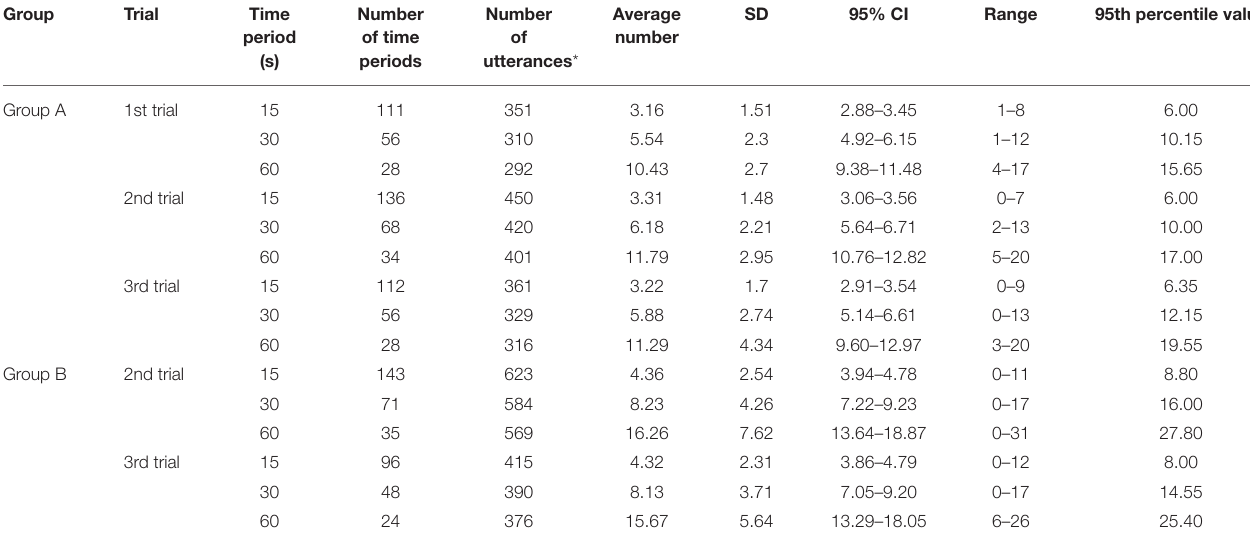
TABLE 2 | Descriptive statistics of utterances.